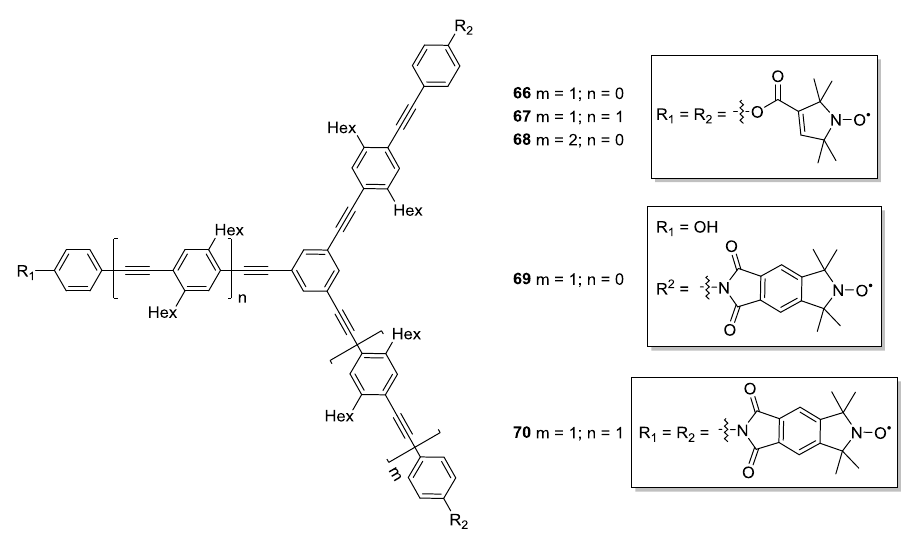
Figure 8. Multi-spin systems with different